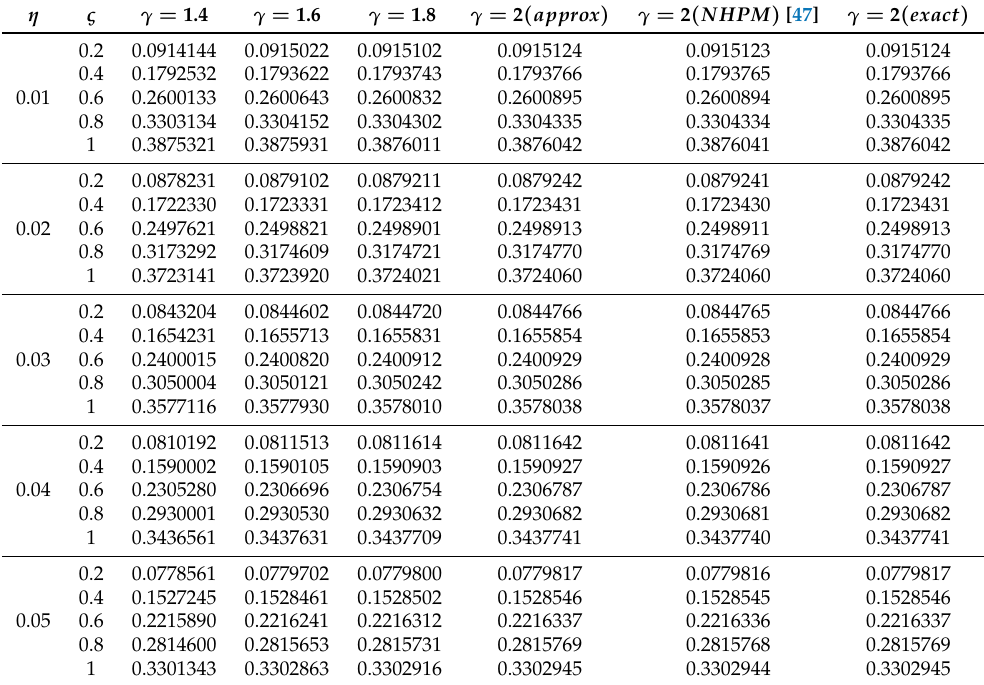
Table 1. Comparison of the accurate and suggested technique solution at different values of γ for problem